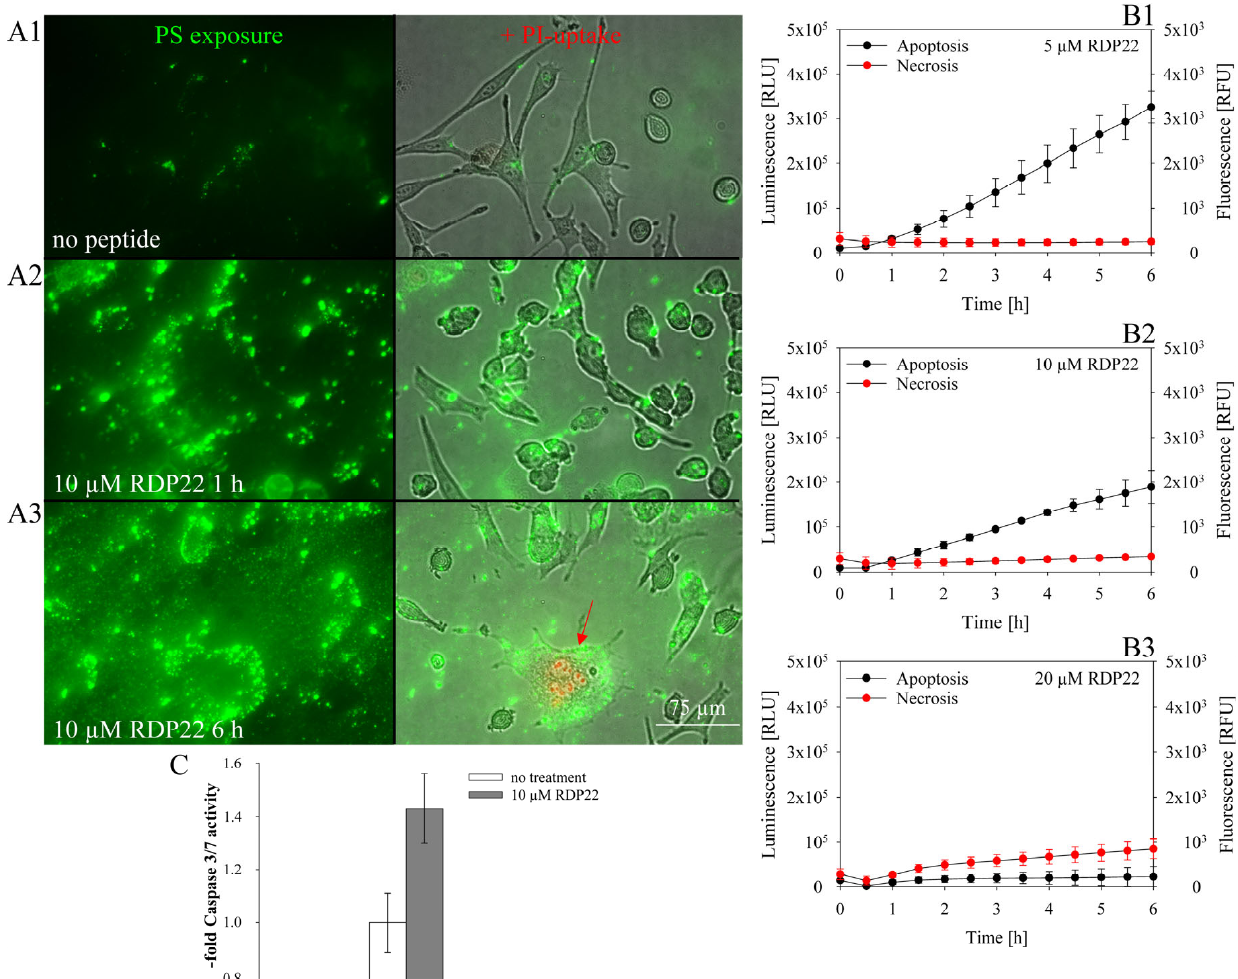
Figure 4. ( A ): Microscopy studies on MUG-Mel2 indicating moderate PS exposure already in the absence ( A1 ) of peptide (green dye Annexin V Alexa 488). Upon 10 µ M peptide incubation for 1 h ( A2 ) to 6 ( A3 ) hours PS exposure strongly increases indicating induction of apoptosis and upon 6 h also induction of cell death by necrosis (arrow, PI-uptake; red). Fluorescence channels for Annexin V Alexa 488 (green, PS exposure) and overlay with bright field and PI (red, cell death) are shown. Microscopy pictures represent the outcome of at least three independent experiments. ( B ): Apoptosis/necrosis induced upon incubation with peptide RDP22 at concentrations of 5 µ M ( B1 ), 10 µ M ( B2 ) and 20 µ M ( B3 ) was investigated. Apoptosis is shown by luminescence with black circles, necrosis is indicated by fluorescence with red circles over 6 h. From 5 to 10 µ M, RDP22 induces cell death by apoptosis. By 20 µ M peptide minor late apoptosis or necrosis starts to be induced. Mean values with standard deviations are derived from five independent data sets. ( C ): Fold caspase-3/7 activity of melanoma cell line MUG-Mel2 after 4 h of incubation with 0 and 10 µ M of peptide RDP22, indicating killing by apoptosis. Mean values represent data from at least three independent